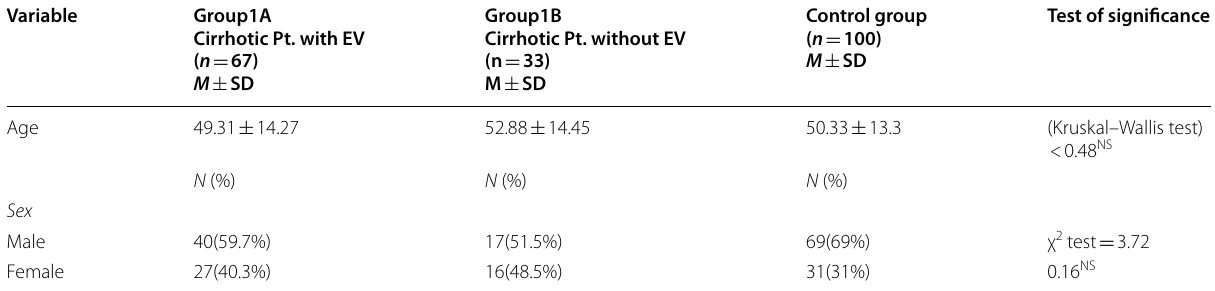
Table 1 Demographic data of the studied